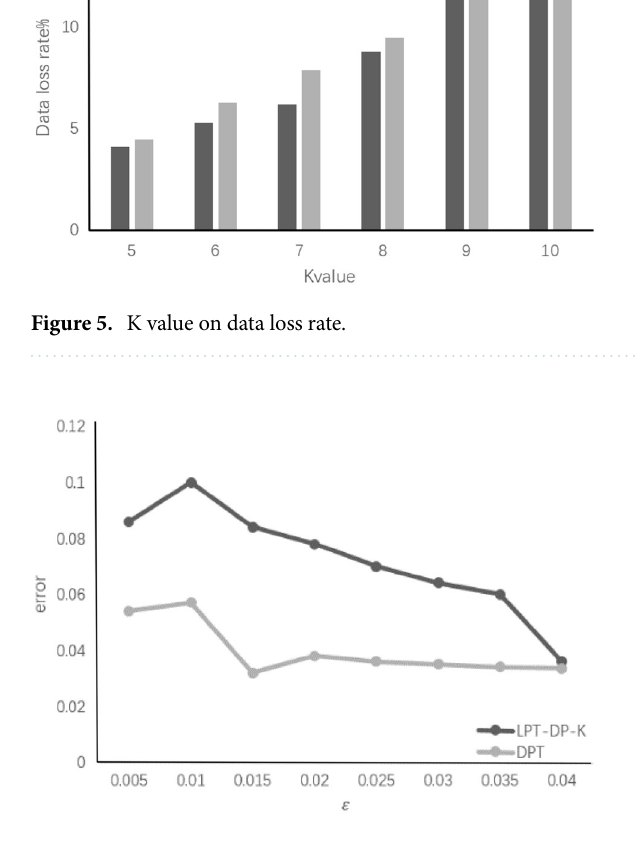
Figure 6. ε impact on